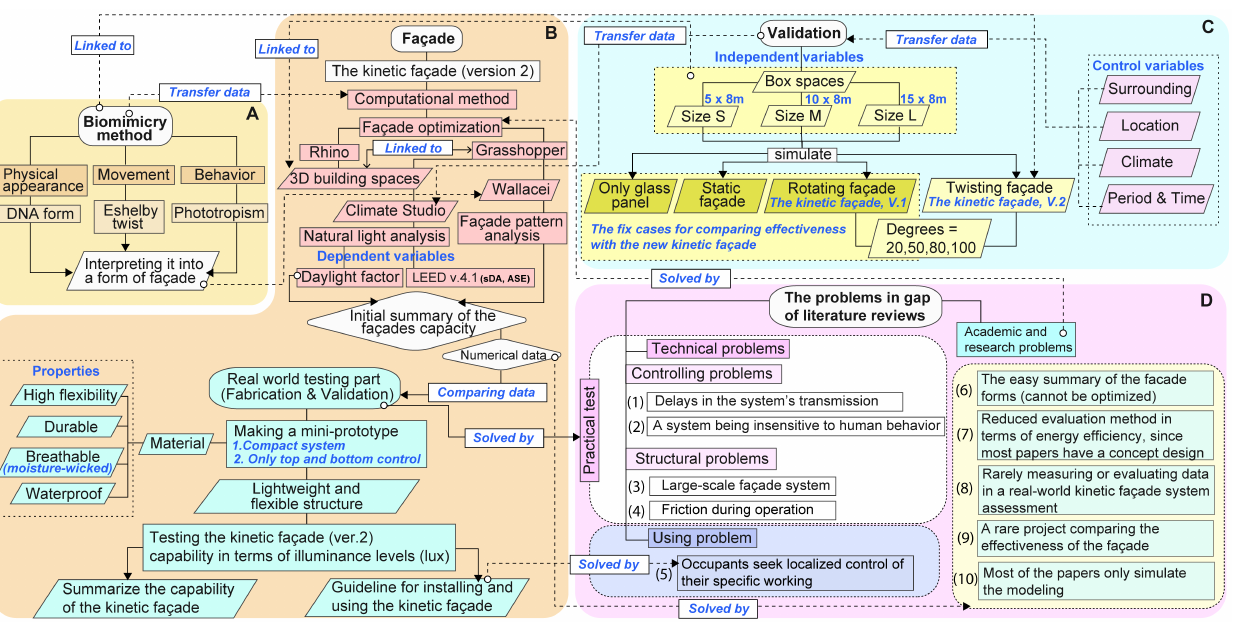
Figure 4. The overall diagram of the research